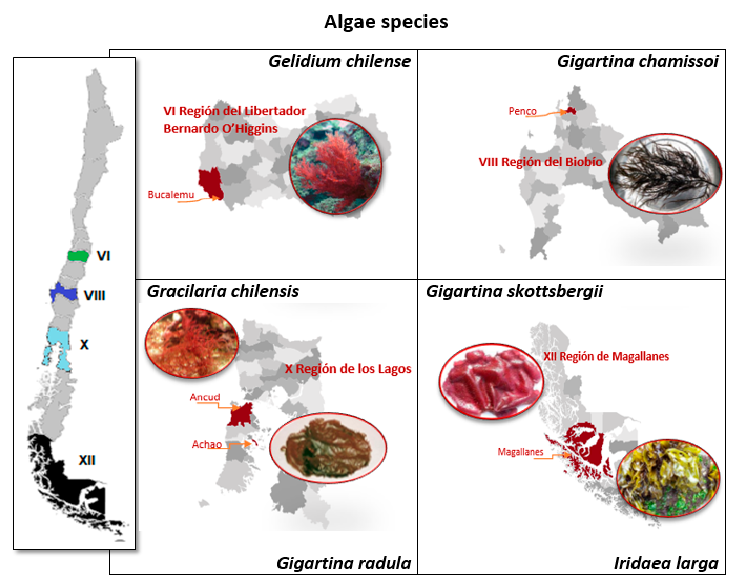
Figure 1. Red algae studied and region of Chile from which they were collected.